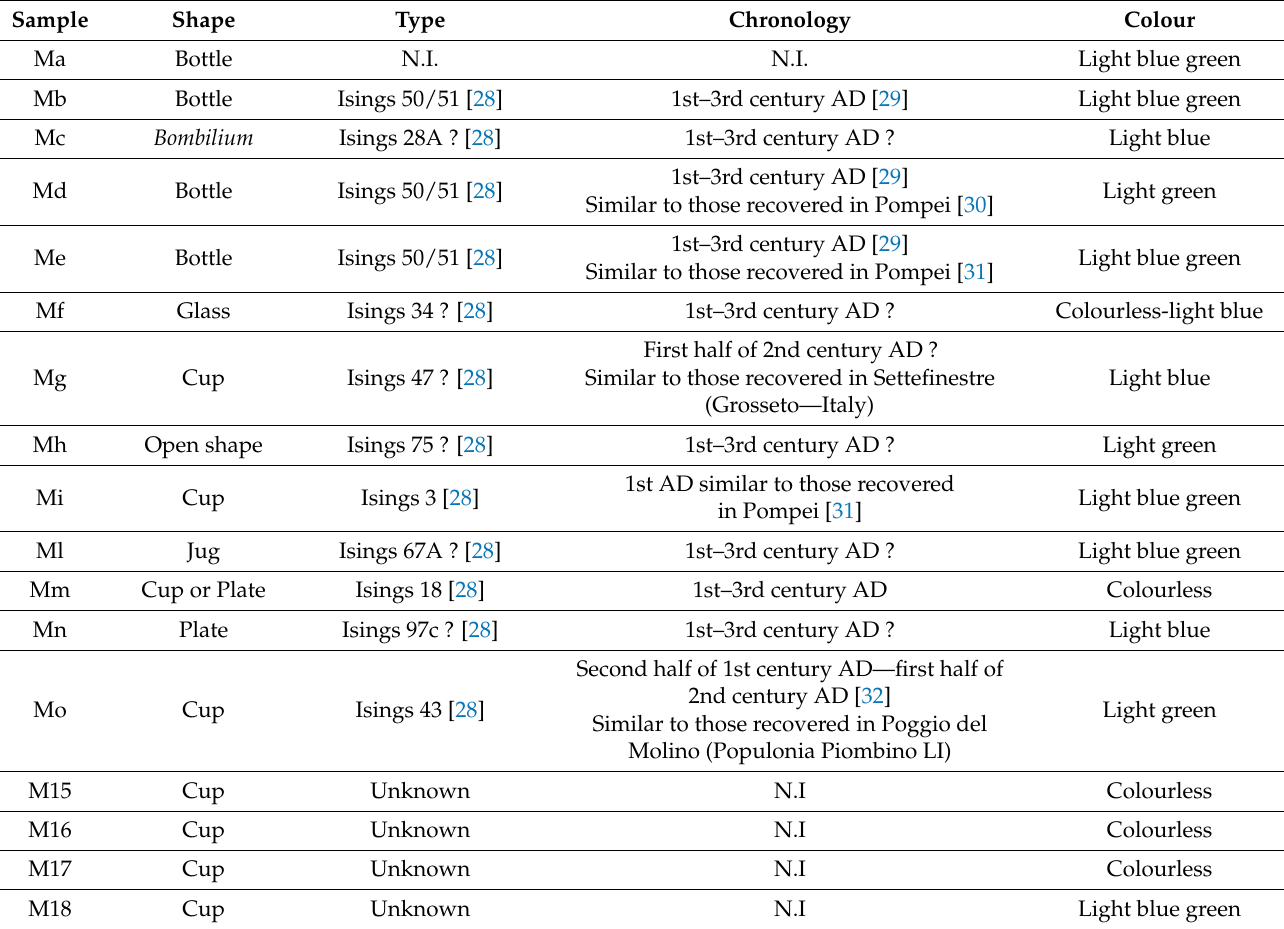
Table 1. Typological analyses of Muricelle vitreous finds (N.I. = not identified; ? = dubious type or